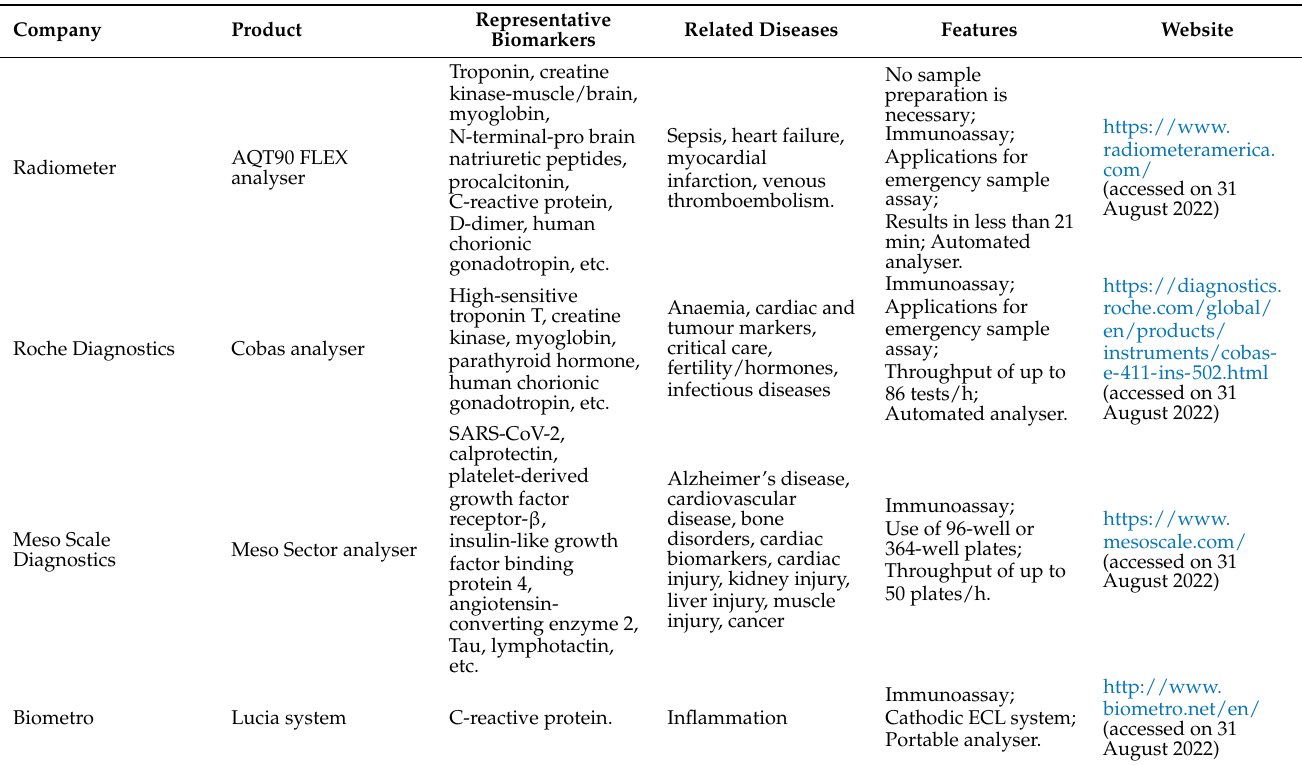
Table 1. Commercialised products and assay kits for the biomarker